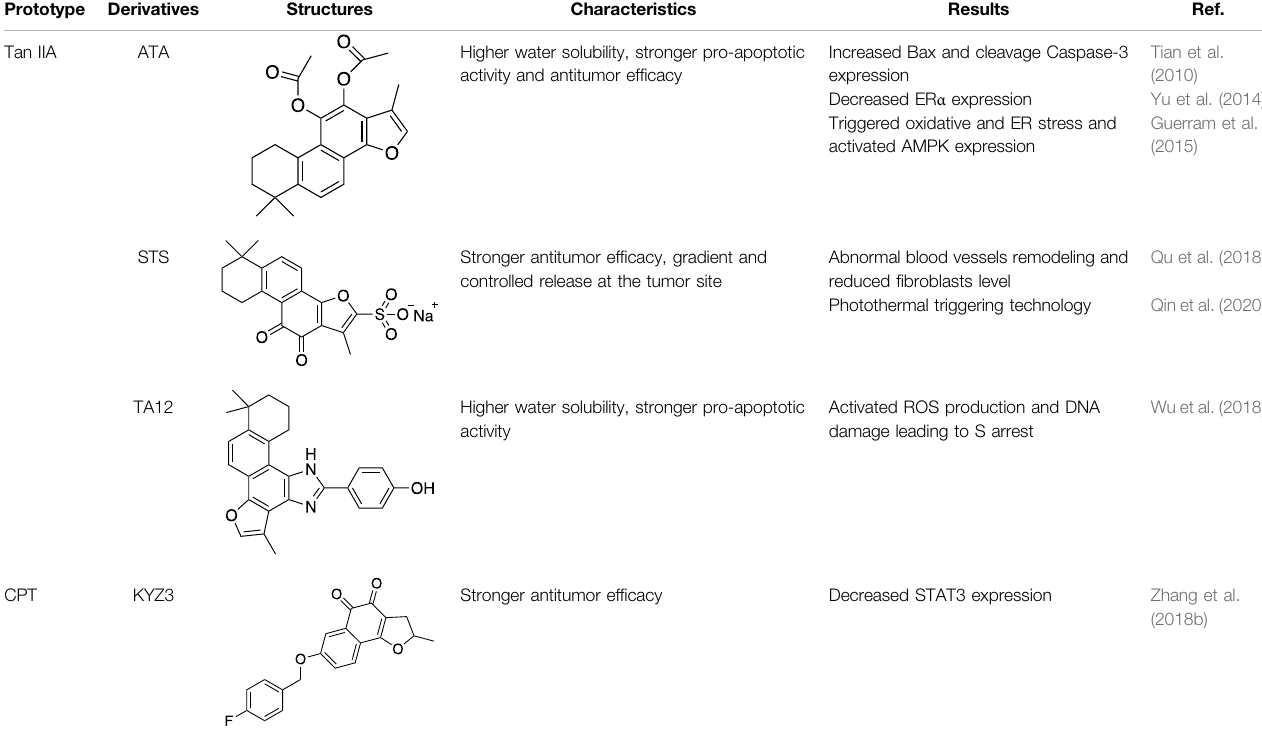
TABLE 2 | The effects of derivatives from S. miltiorrhiza bioactive constituents for breast cancer treatment. Prototype